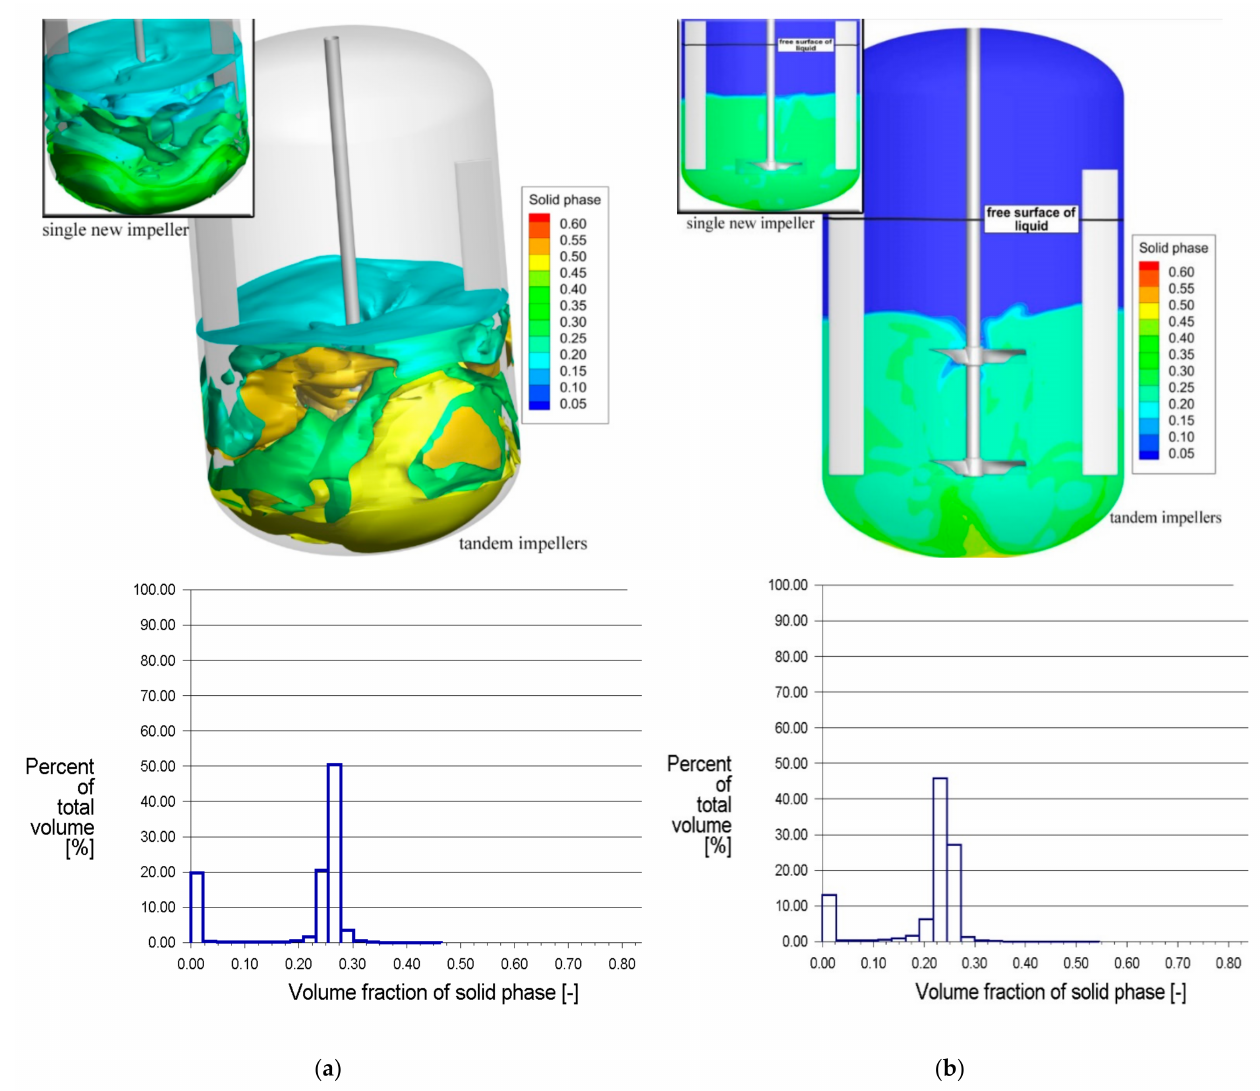
Figure 3. Final state of the volume fraction distribution of the solid phase, instantaneous results: ( a ) single new impeller; ( b ) new impellers in